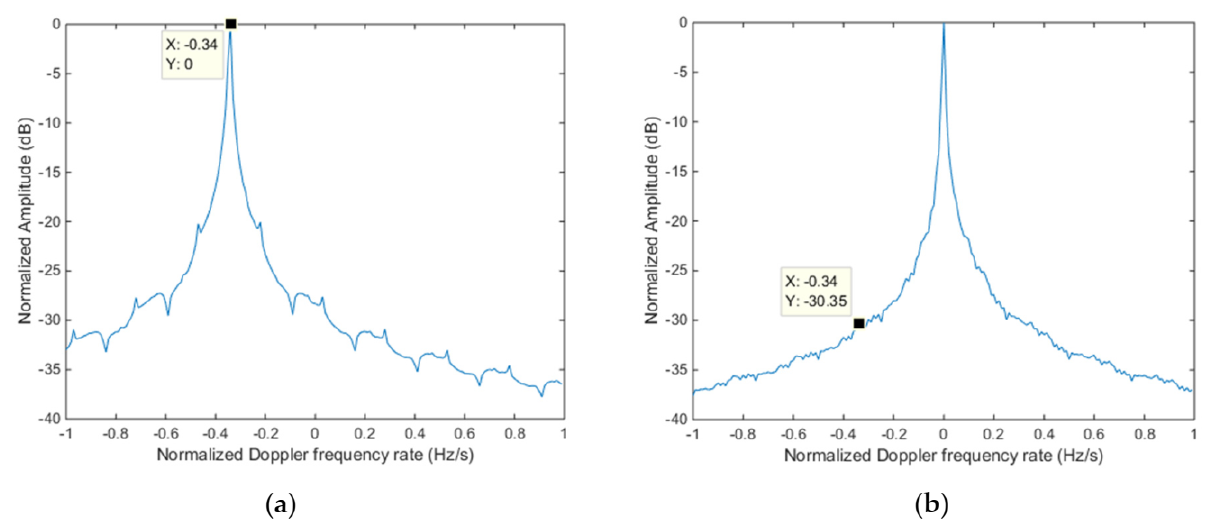
Figure 7. The distribution results of the target and the clutter. ( a ) The target echo in DFR domain; ( b ) The clutter echo in DFR domain.